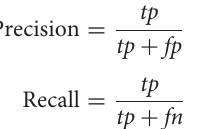
Frontiers in Plant Science |